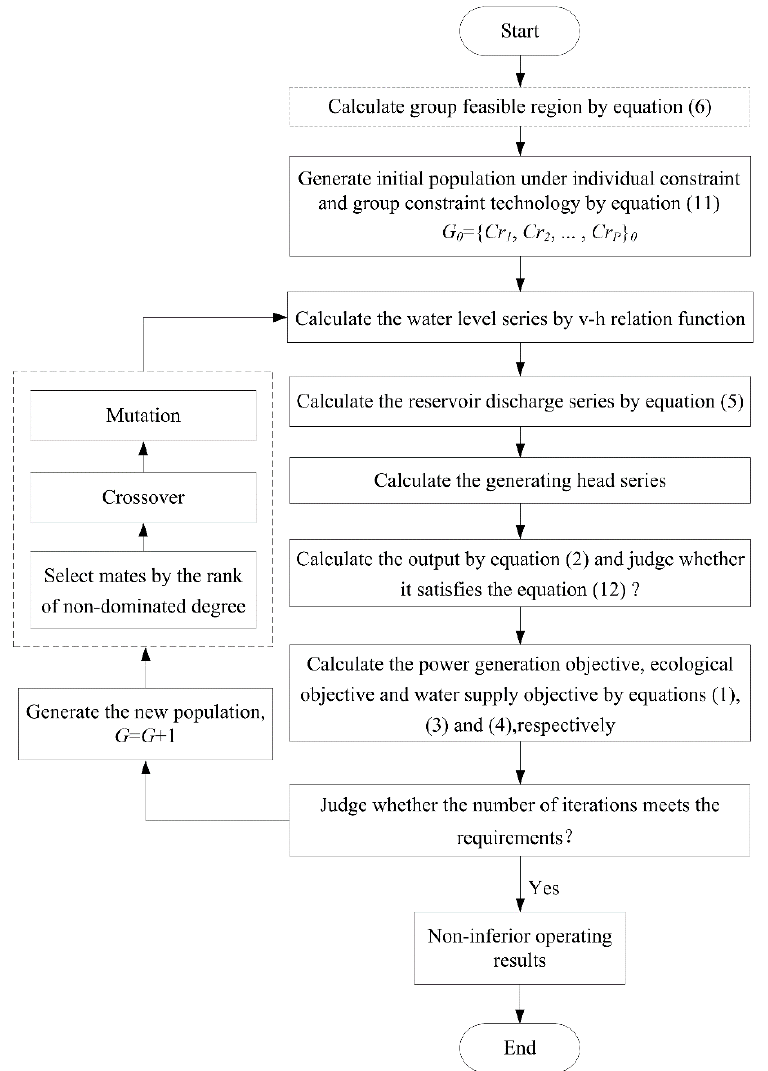
Figure 3. Flow chart of shrinking the feasible search space. Table 3. Ecological flow